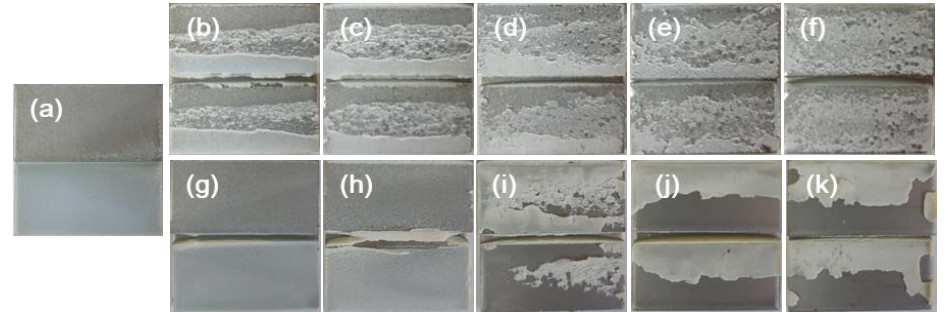
Figure 13. Fracture surfaces of epoxy adhesives obtained by lap shear test: ( a ) control; ( b ) 5 wt % PTPU; ( c ) 10 wt % PTPU; ( d ) 15 wt % PTPU; ( e ) 20 wt % PTPU; ( f ) 30 wt % PTPU; ( g ) 5 wt % CTBN; ( h ) 10 wt % CTBN; ( i ) 15 wt % CTBN; ( j ) 20 wt % CTBN; and, ( k ) 30 wt % CTBN.